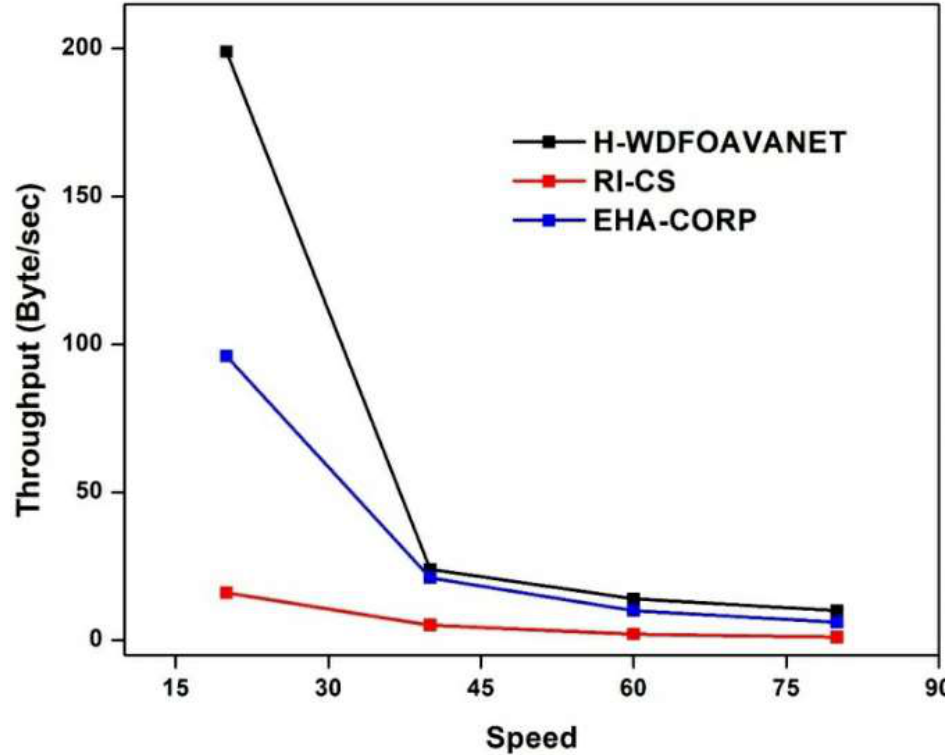
Figure 22. Plots of speed vs. drop in the suggested approach and existing approaches.